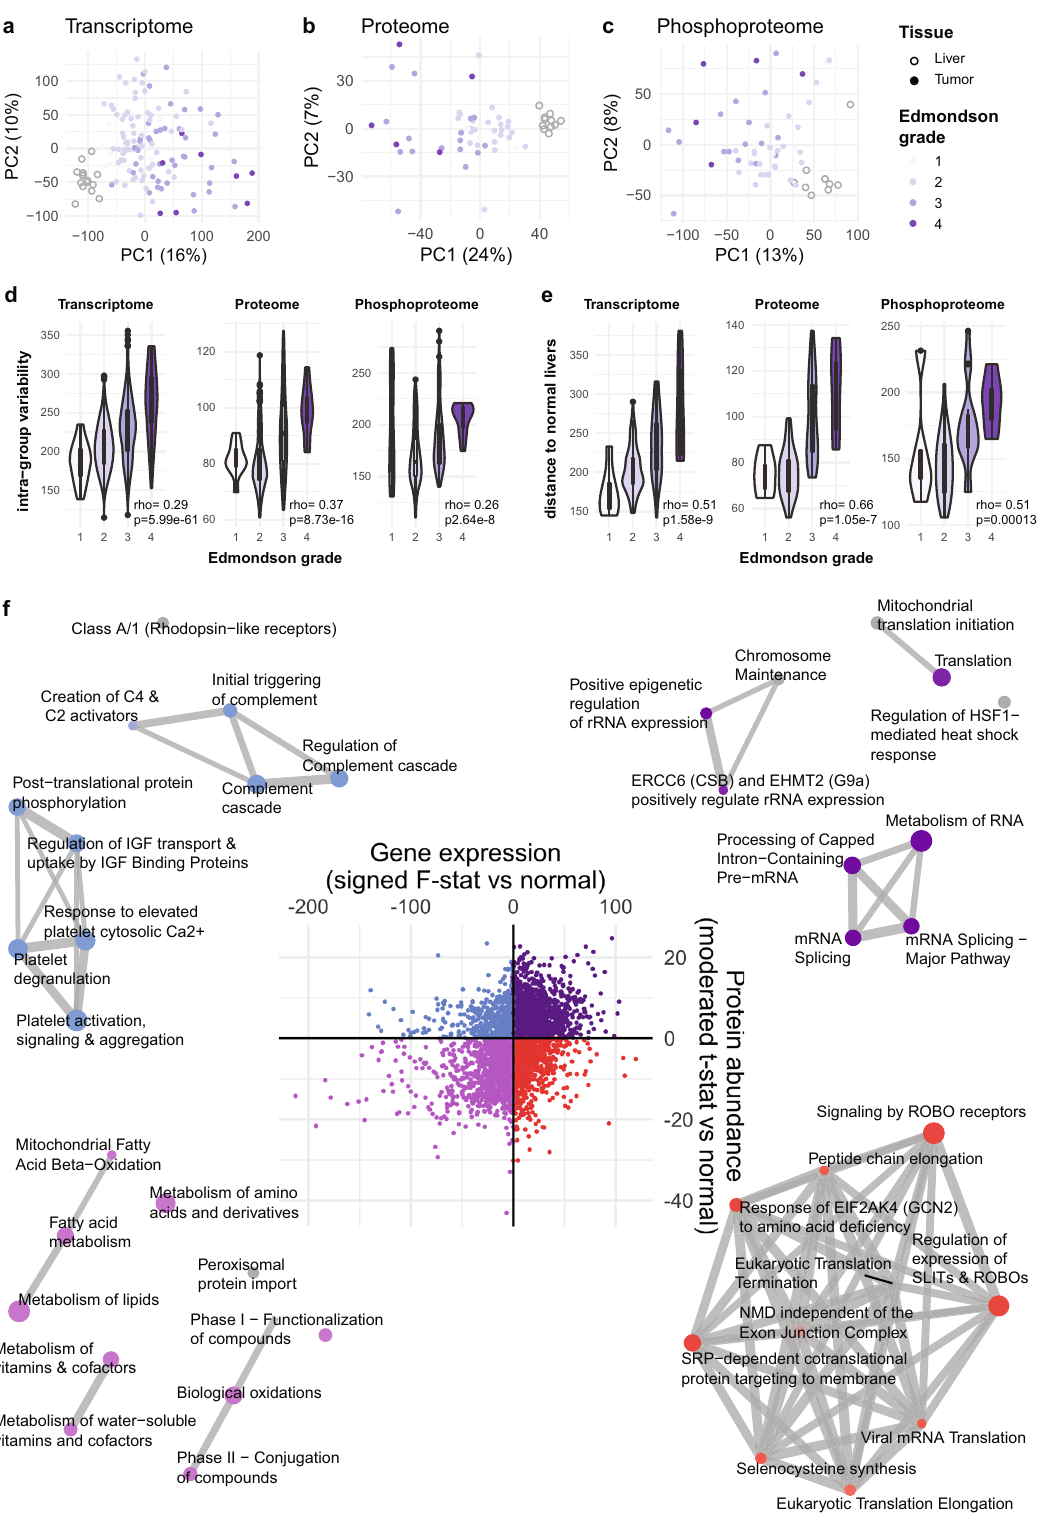
dysregulated on the mRNA level, 11 were dysregulated on the protein level, and 9 were dysregulated on both levels ( ATP6V1C1 , BYSL , CHD1L , NUDCD1 , LRRC47 , RRM2B , UBQLN4 , XPO5 , YWHAZ ). Among this group of genes were known cancer genes such as CHD1L (Chromodomain Helicase DNA Binding Protein 1 Like, 1q21.3 peak) 16 and YWHAZ (14-3-3 zeta, 8q22.2) 17,18 (Fig. 2d inset).